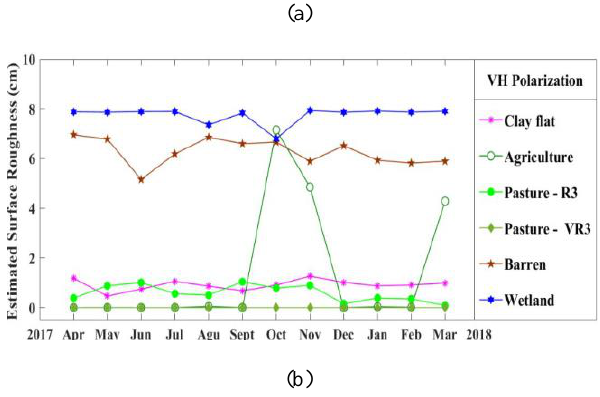
Figure 4. Estimated Surface Roughness obtained from (a) VV and (b) VH polarizations between April 2017 and March